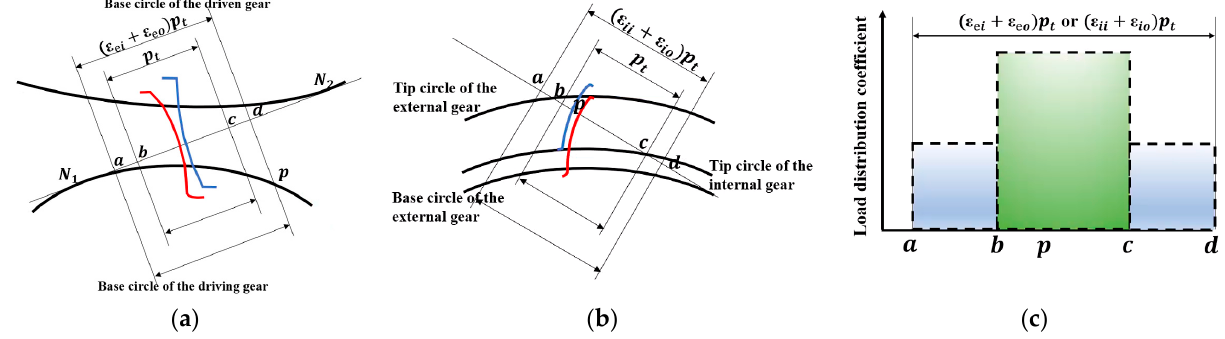
Figure 3. Schematic diagram of two kinds of gear meshing: ( a ) external meshing; ( b ) internal meshing; and ( c ) load distribution coefficient.